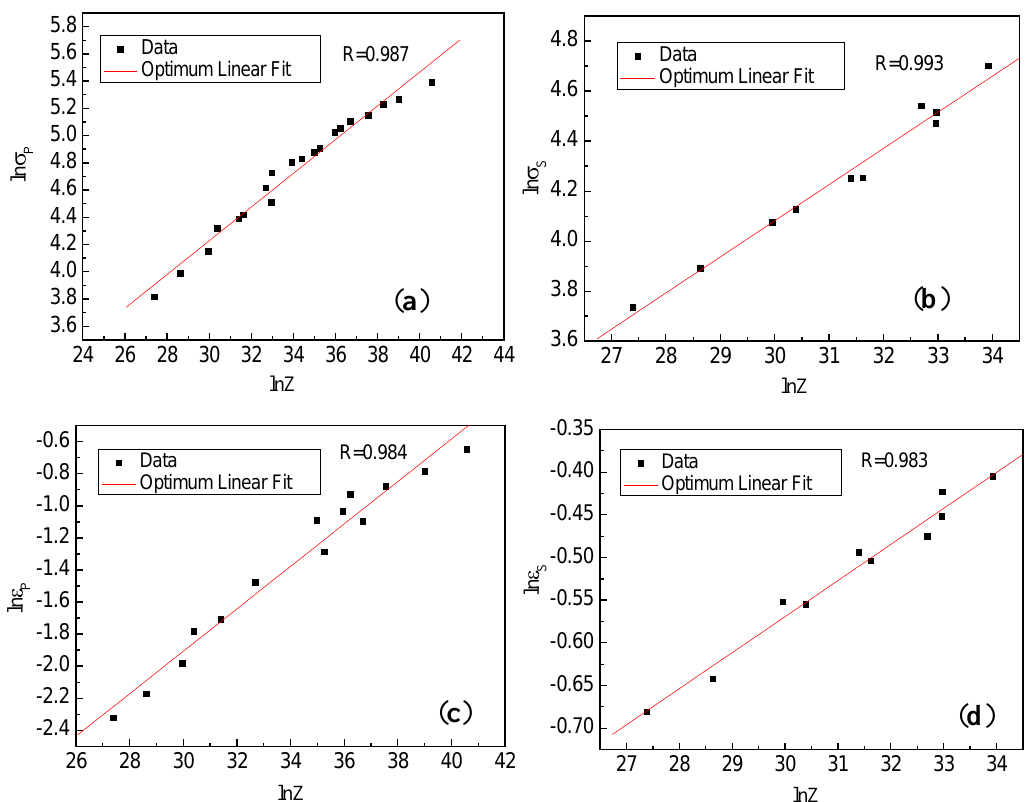
Figure 7. Relations between ( a ) peak stress and Z , ( b ) steady-state stress and Z , ( c ) peak strain and Z and ( d ) steady-state strain and Z .